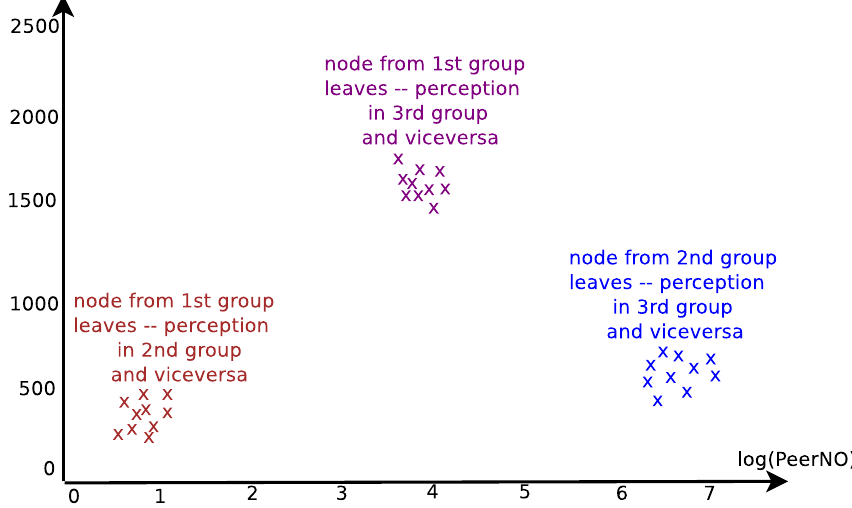
Figure 6. The extra time needed by the DHT to re-stabilize after a peer join or a peer